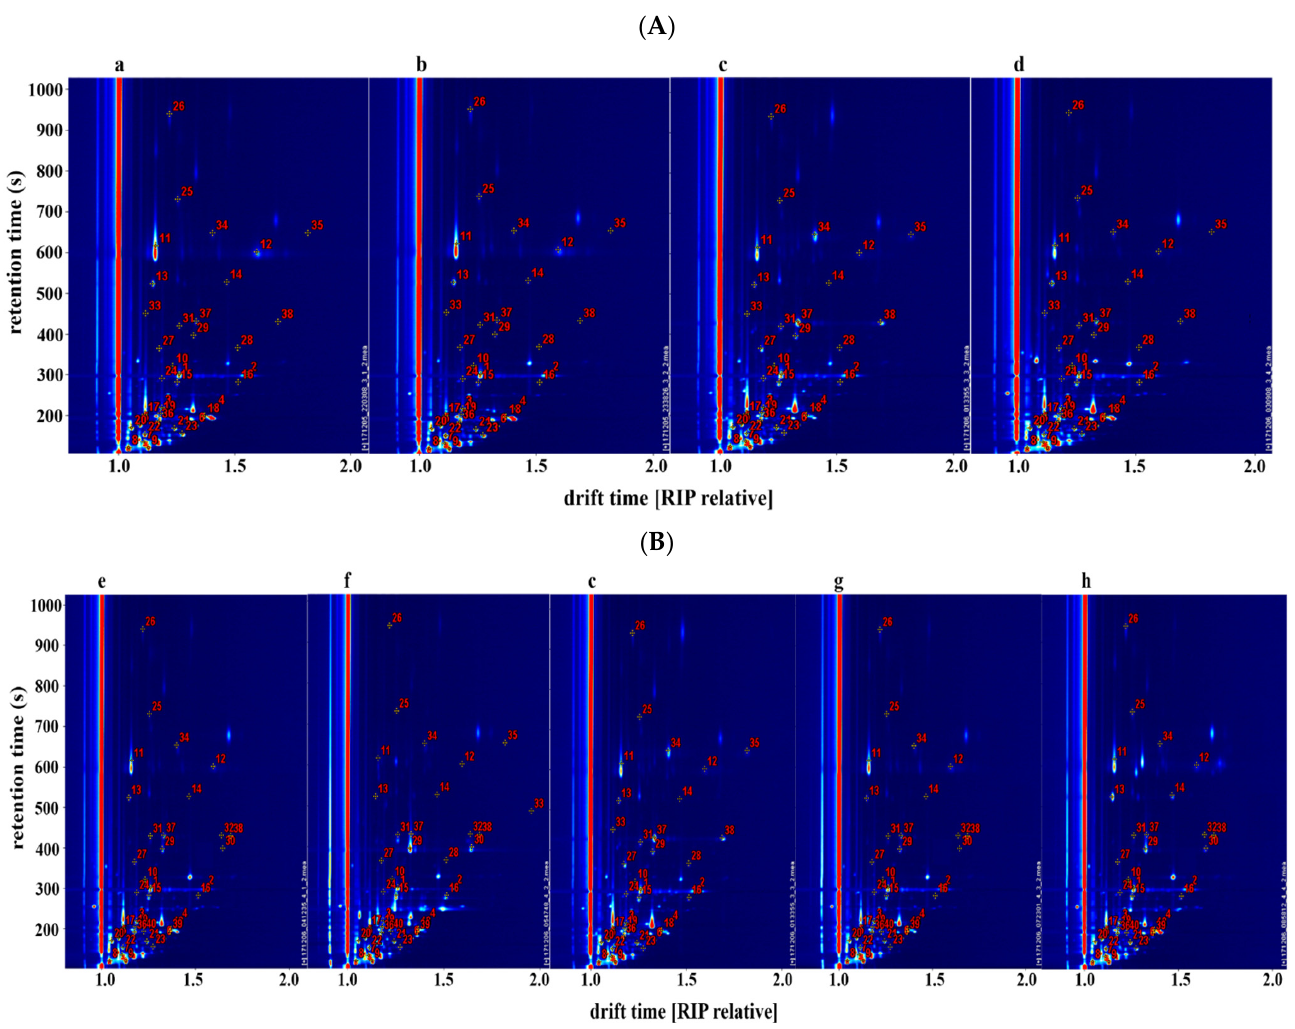
Figure 1. Topographic plots of GC–IMS spectra with the selected markers obtained from T. matsutake samples at different frying temperatures ( A ) and frying times ( B ): ( a ) 100 °C, 80 s; ( b ) 120 °C, 80 s; ( c ) 160 °C, 80 s; ( d ) 200 °C, 80 s; ( e ) 160 °C, 40 s; ( f ) 160 °C, 60 s; ( g ) 160 °C, 100 s; and ( h ) 160 °C, 120 s. The numbers correspond to the identified signals.